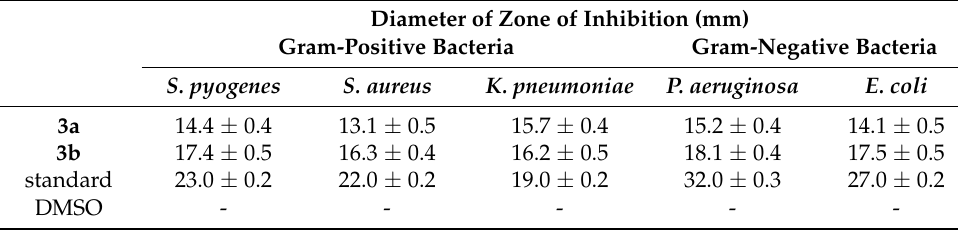
Table 7. Antibacterial activity (diameter of zone of inhibition, mm, of compounds 3a – b ).